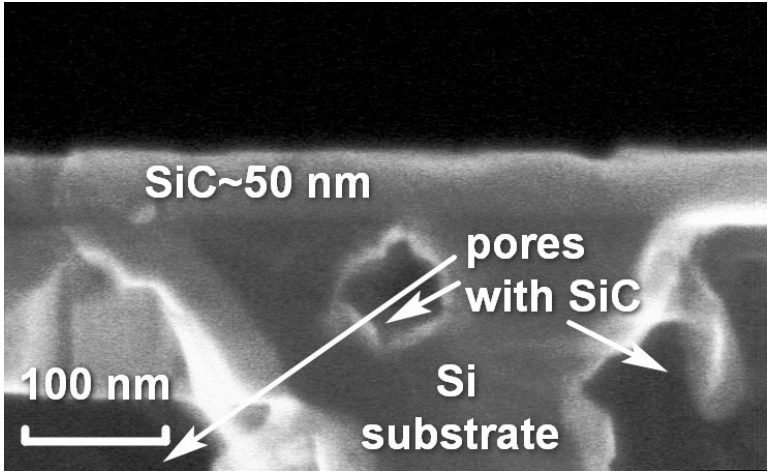
Figure 1. Micrograph of a section of a 3C-SiC(111)/silicon (Si)(111) sample grown by the method of substitution of atoms.